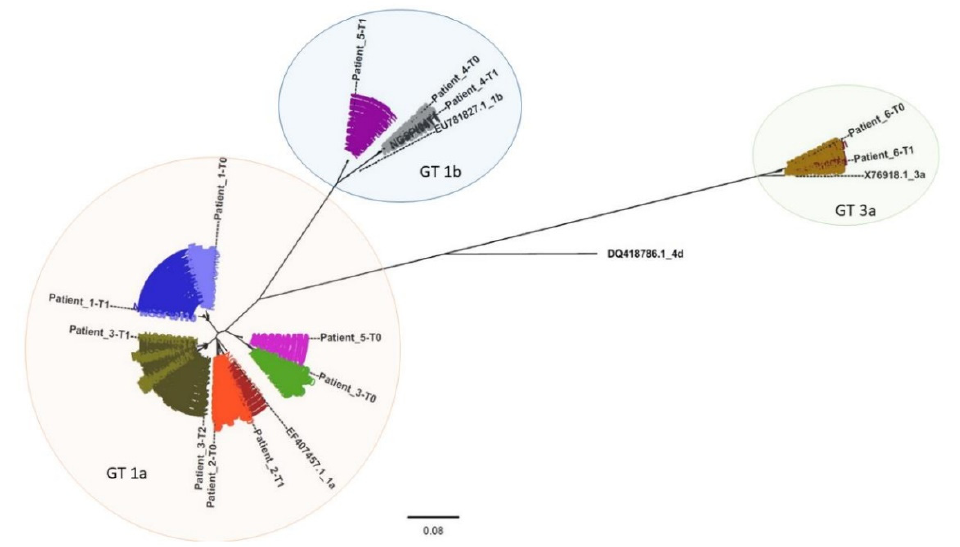
Figure 2. HCV NS5B phylogenetic tree. The maximum-likelihood method with the transition-free rate model and empirical codon frequencies was employed to build the NS5B phylogenetic tree. The HCV GT4d sequence (DQ418786.1) was selected as an out-group. Reference sequences (GT1a: EF407457.1; GT1b: EU781827.1; GT3a: X76918.1) were retrieved from GenBank. Sanger sequences for all patient samples were included and indicated as Patient_N-T0, Patient_N-T1, and Patient_N-T2. The bar represents the genetic distance (substitution per nucleotide position). Bootstrap analysis with 1000 replicates was performed. Each patient is represented by a different color: Pt1_T0 and Pt1_T1 are depicted in light and dark blue, respectively; Pt2_T0 and Pt2_T1 are depicted in light and dark red, respectively; Pt3_T0, Pt3_T1, and Pt3_T2 are depicted in light green, olive green, and dark olive green, respectively; Pt4_T0 and Pt4_T1 are depicted in light and dark grey, respectively; Pt5_T0 and Pt5_T1 are depicted in light and dark violet, respectively; Pt6_T0 and Pt6_T1 are depicted in light and dark brown, respectively. The orange, blue, and green circled areas represent sequences clustering with GT1a, GT1b, and GT3a, respectively.